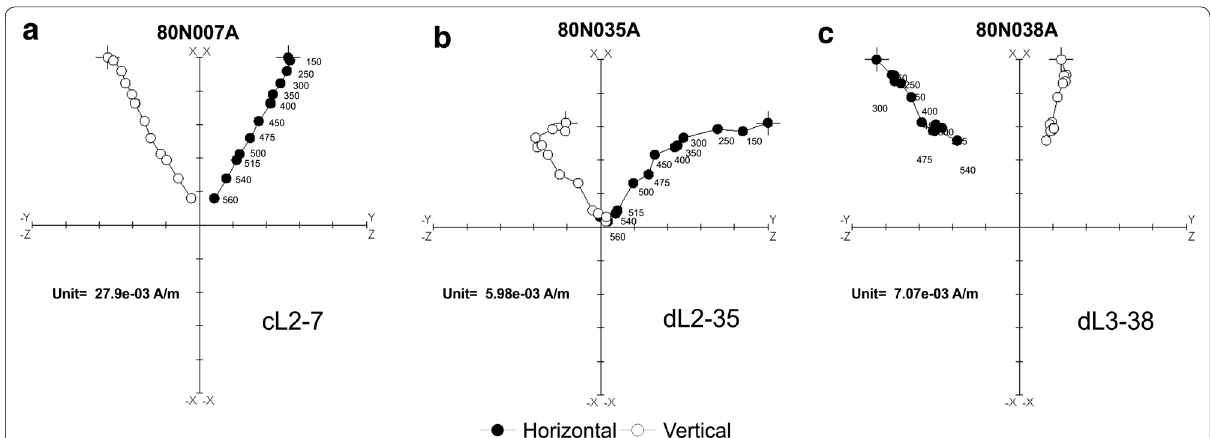
Fig. 15 Representative normalized orthogonal vector plots (Zijderveld diagrams) of stepwise thermally demagnetized samples from a ceramic sherd cL2, b ceramic sherd dL2 and c ceramic sherd dL3. Labels along horizontal curves denote the temperature during the demagnetization step. See text for more